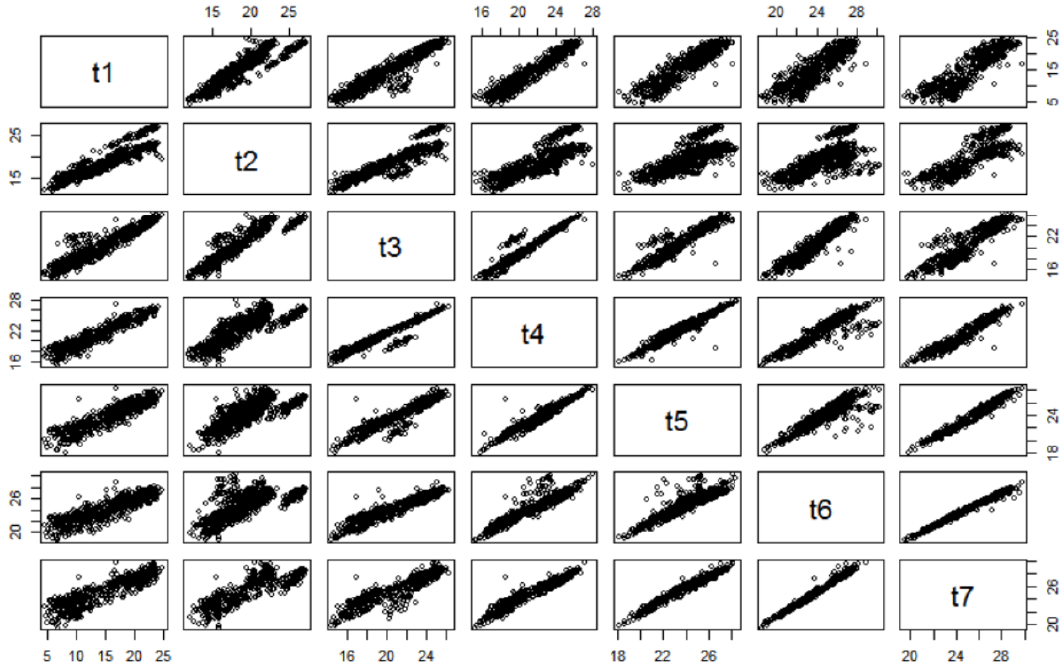
Figure 3. Scatter plot of the effective temperatures (°C) measured in situ, corresponding to the seven nodes.